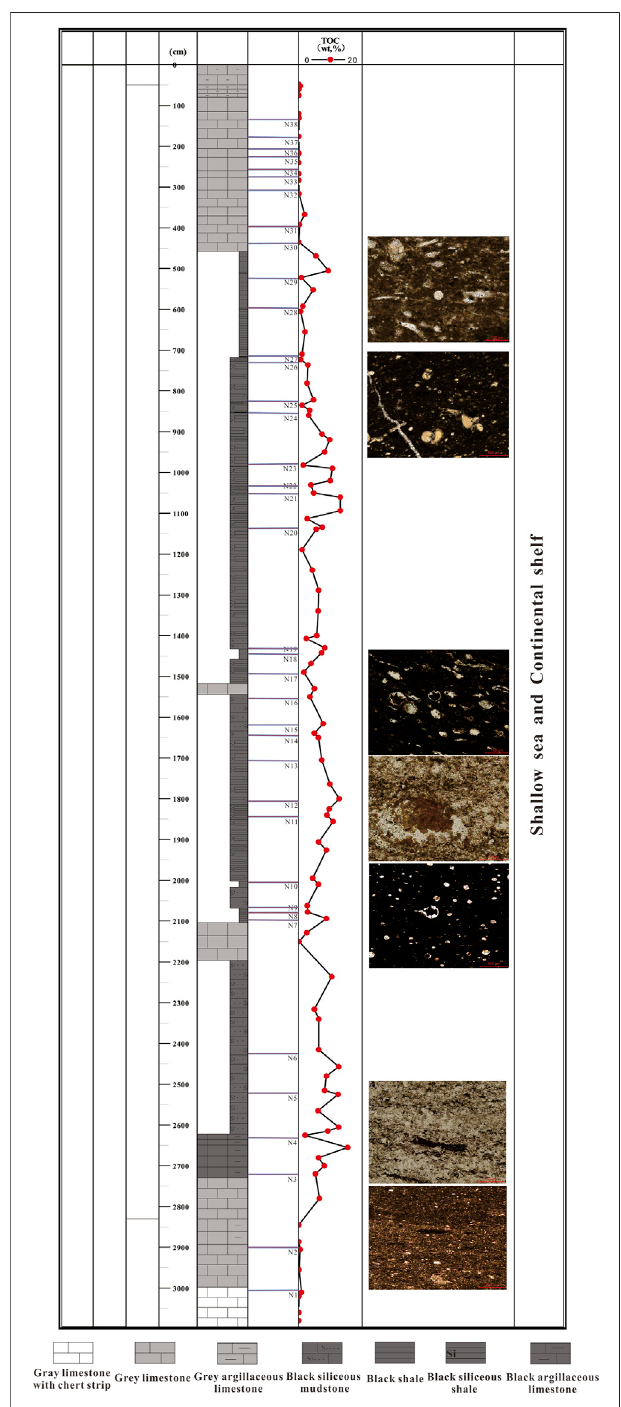
FIGURE 8 | Vertical variation of organism types in Dalong Formation in Longfeng quarry